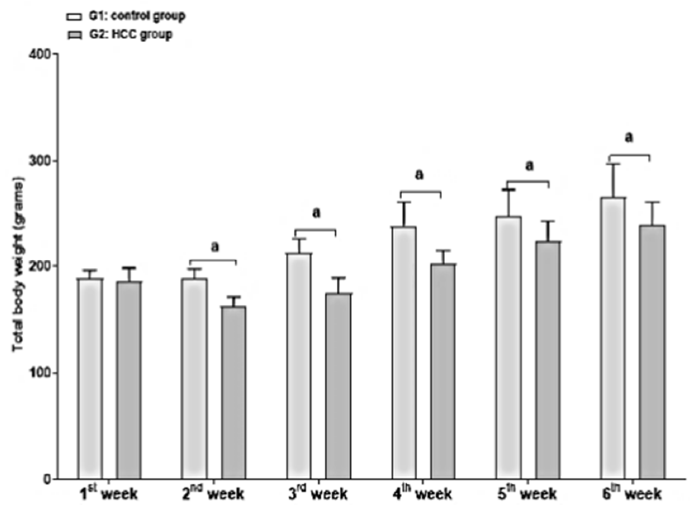
Figure 2. Body weight (grams) during the first to sixth weeks of the control (G1) and HCC-induced rat (G2) groups. a: significance versus G1. Significance at p < 0.050. Table 2. Initial and end changes in body weight, liver weight and liver index in the study groups following HCC treatment (from week 7 to week 13) by sorafenib, quercetin or both molecules. Groups 1 and 2 are non-induced and HCC-induced rats, respectively. Groups 3, 4 and 5 correspond to HCC-induced rats treated with quercetin, sorafenib and sorafenib/quercetin, respectively.